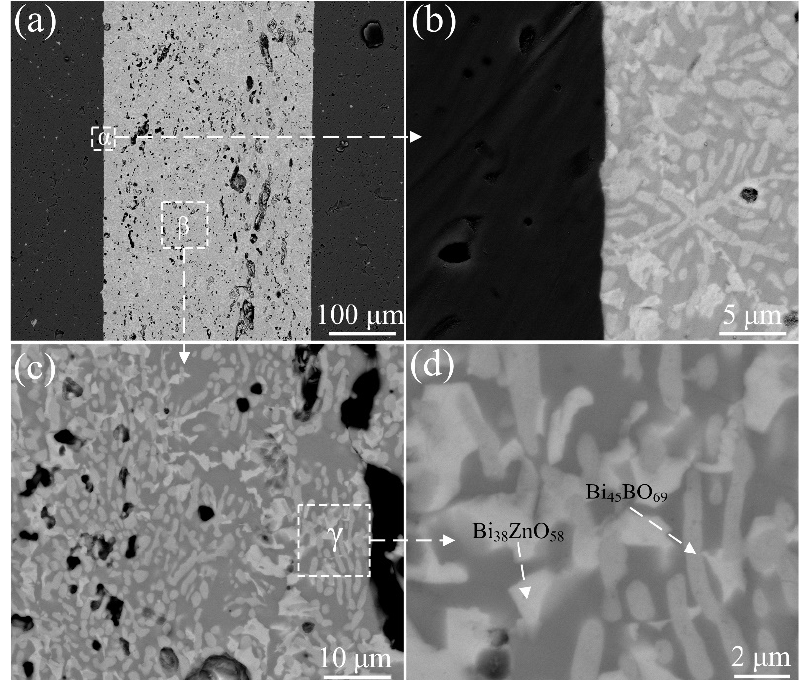
Figure 3. ( a ) Microstructure of the ferrite joint brazed with the glass under the joining temperature of 551 °C for 20 min; ( b – d ) high magnification morphology of the selected area of α , β and γ , respectively.